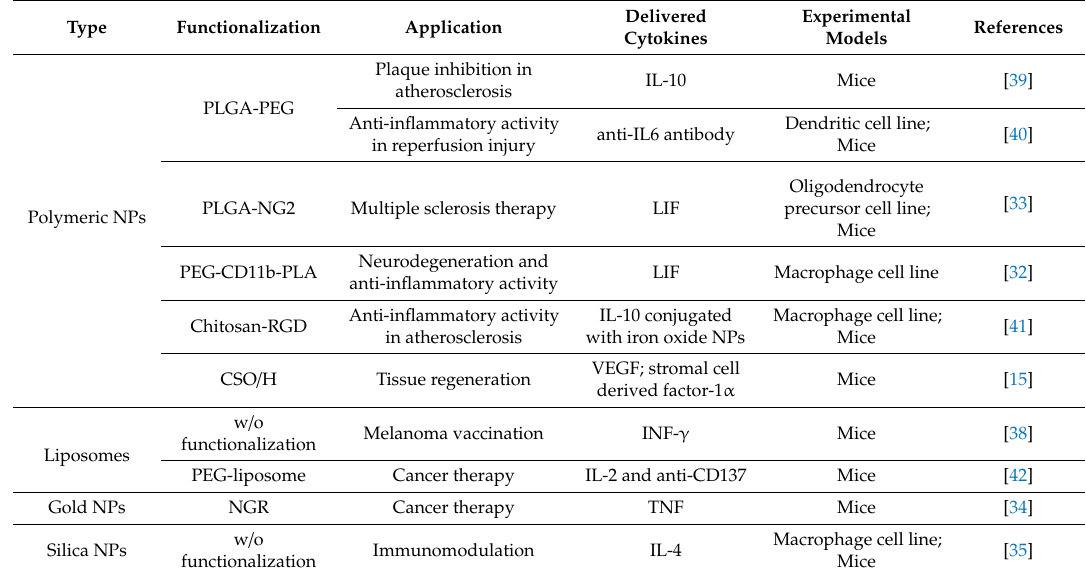
Table 1. Nanoparticle-based systems for the delivery of cytokines and applications in biomedicine.